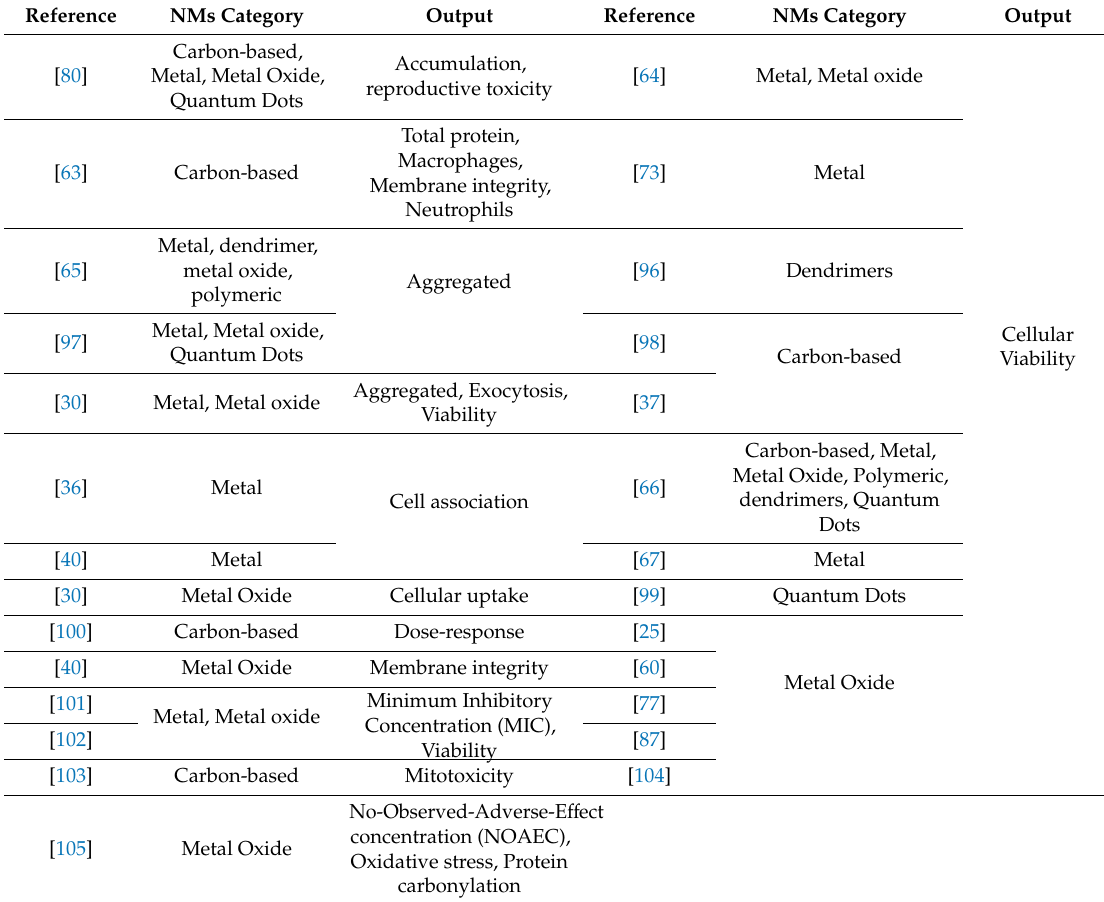
Table 3. Endpoints predicted by trees category extracted from the studies